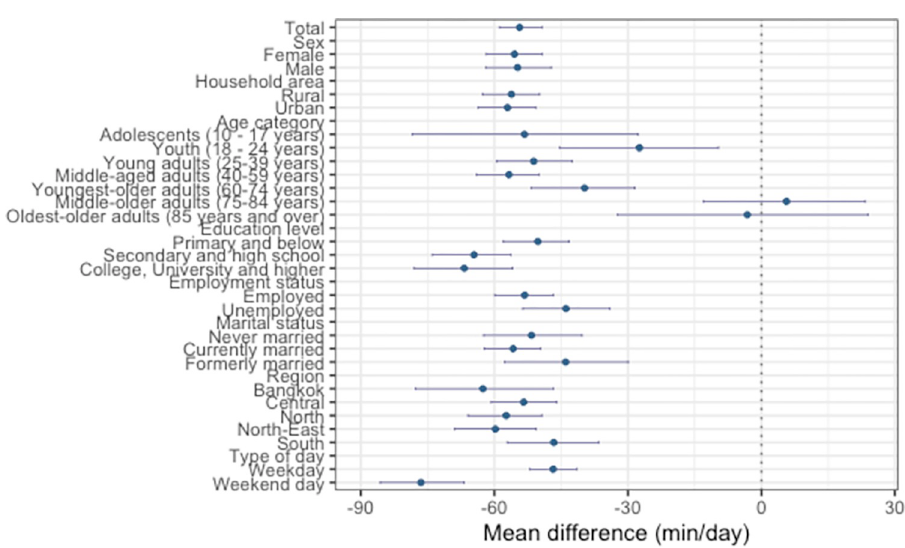
Fig 2. Mean difference in physical activity from 2009 to 2015. Mean changes in physical activity from 2009 to 2015 (circles) and their 95% bootstrap confidence intervals (whiskers).